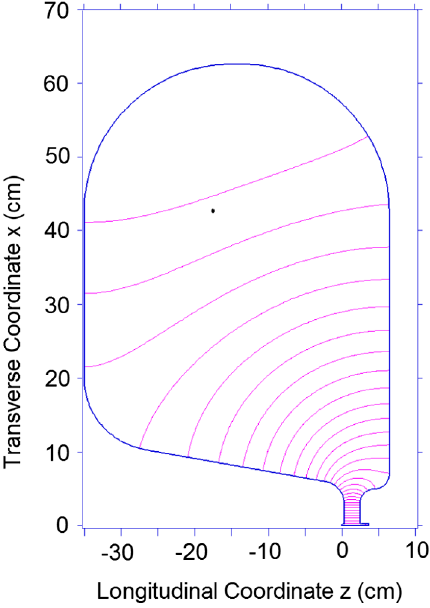
FIG. 8. The geometry and electric field distribution in the rf gun cavity designed with